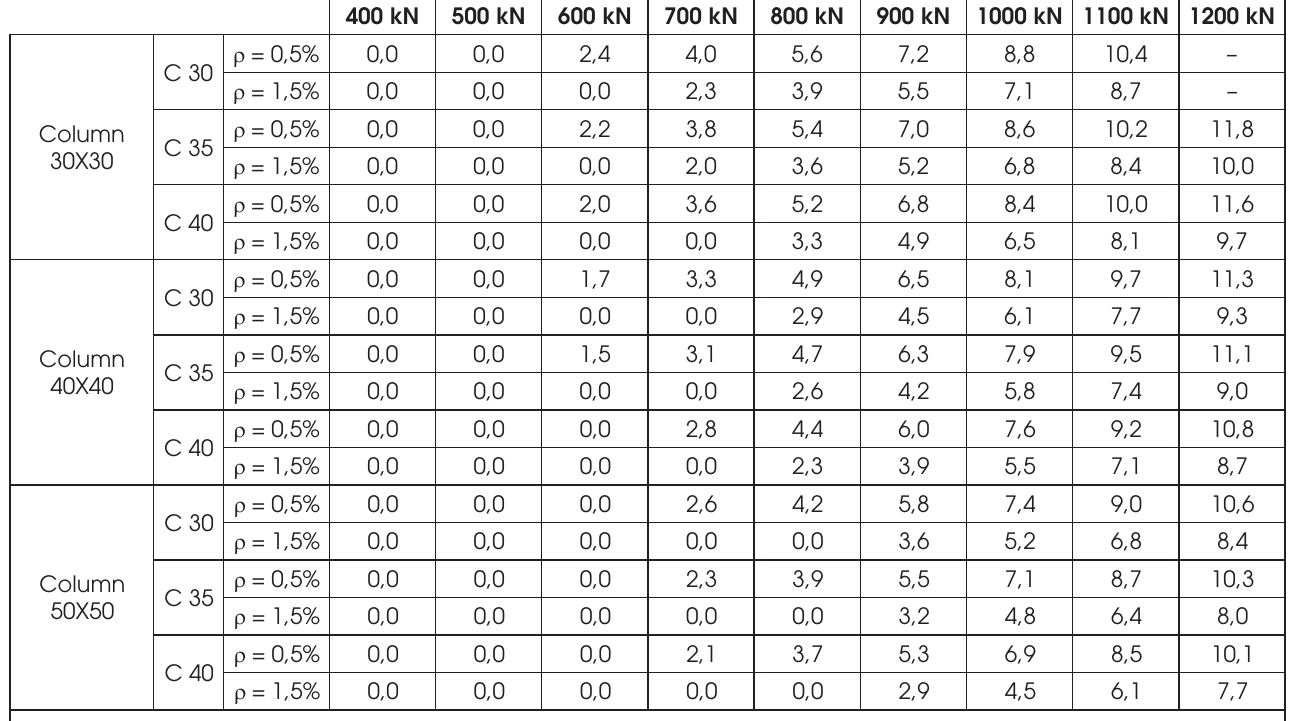
Area of shear reinforcement (cm²) by NBR 6118:2014 (analysis 2) 400